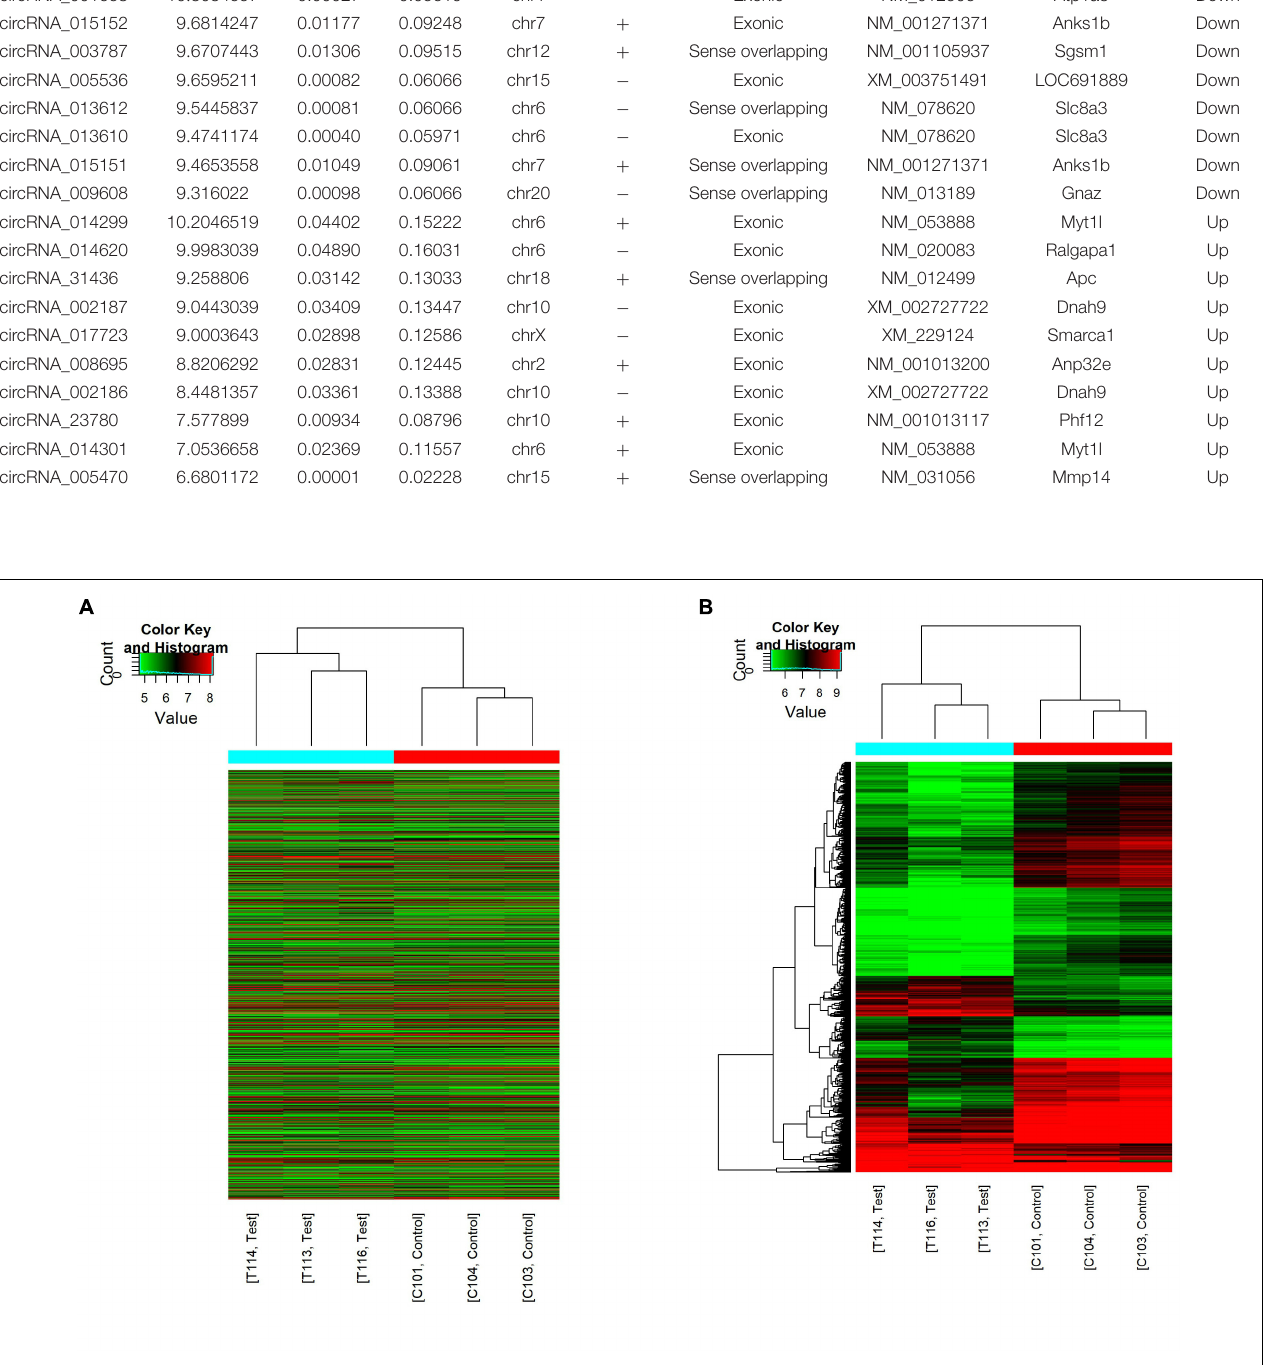
FIGURE 1 | Hierarchical clustering of circRNA expression. C101/103/104 refers to the cord samples from the sham control group, and T113/114/116 refers to the cord samples from the SCI group. (A) Hierarchical clustering analysis included all 13279 circRNAs between the sham control and the SCI groups. (B) Hierarchical clustering analysis included differentially expressed circRNAs (fold change ≥ 2; P < 0.05) between the sham control and the SCI